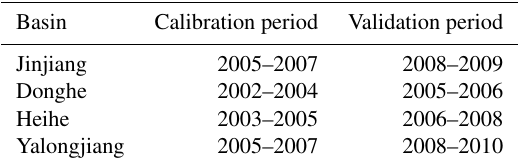
Table 2. The calibration and validation periods for the benchmark calibrations of the four basins.